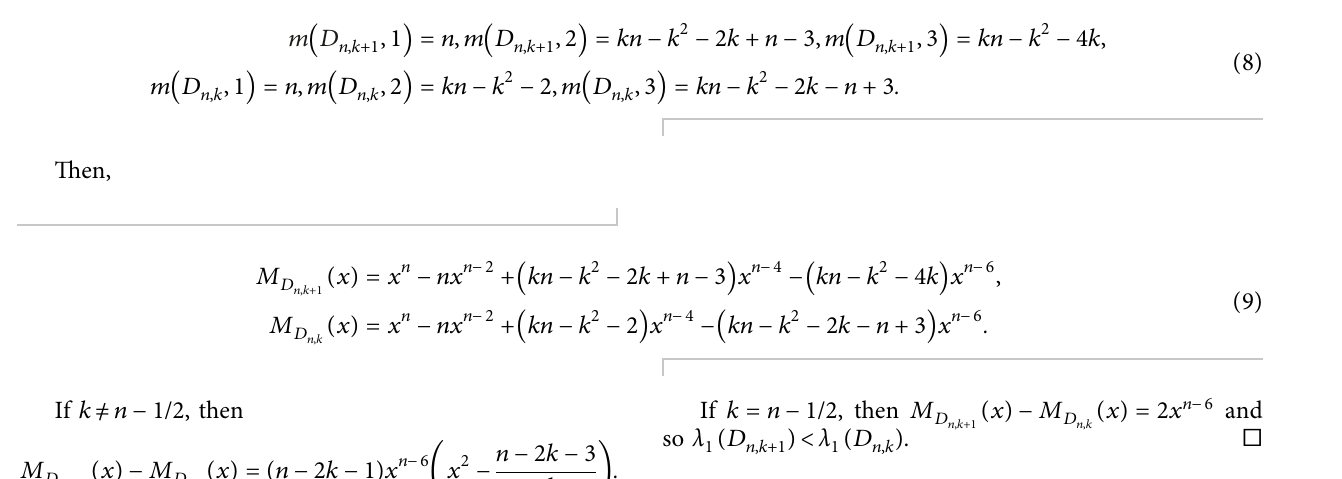
Figure 5. If 2 ≤ k ≤ n − 3 / 2 , then λ